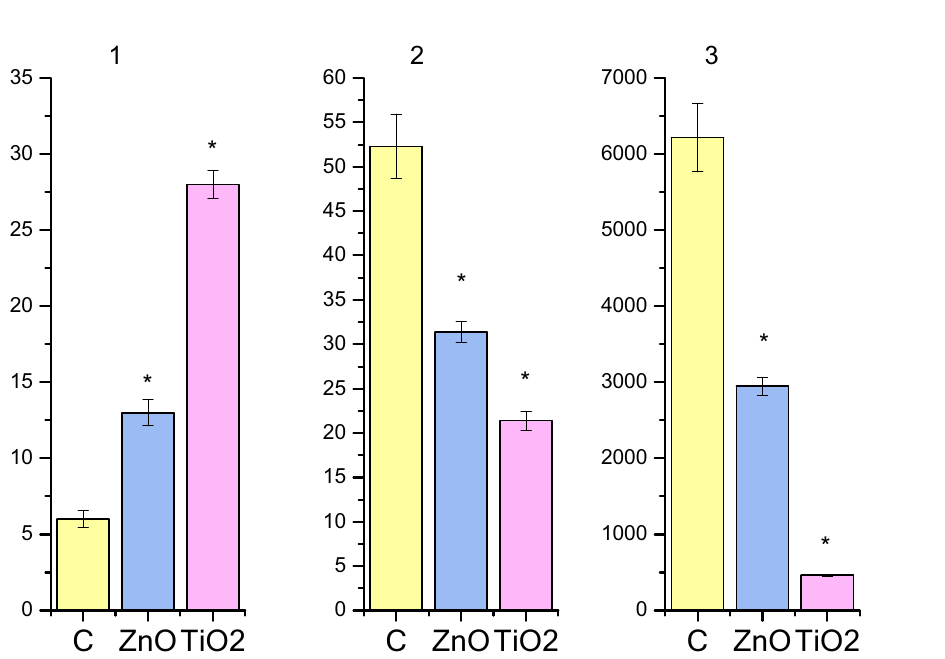
Figure 4. Histograms of the kinetic parameters for the spontaneous contractile activity of the circular SMs of the antrum of rats burdened with ZnO and TiO 2 ANs for 6 months: C—control; ( 1 ) the frequency of contractions of preparations per 10 min.; ( 2 ) an averaged value of the duration of the contraction–relaxation cycle; ( 3 ) AU index of contractions; * p < 0.05 indicates reliability of changes as compared with the